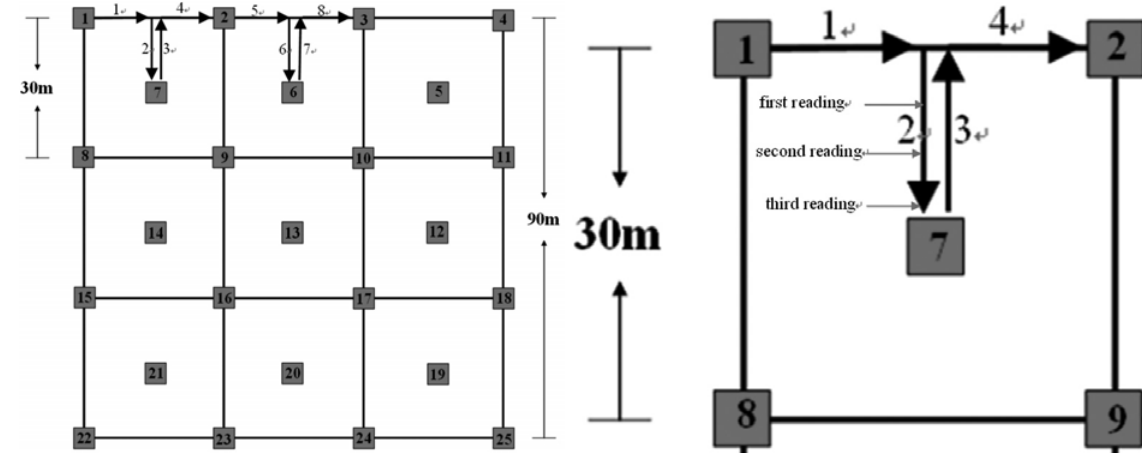
Figure 3. The routes of measurement in the plots.